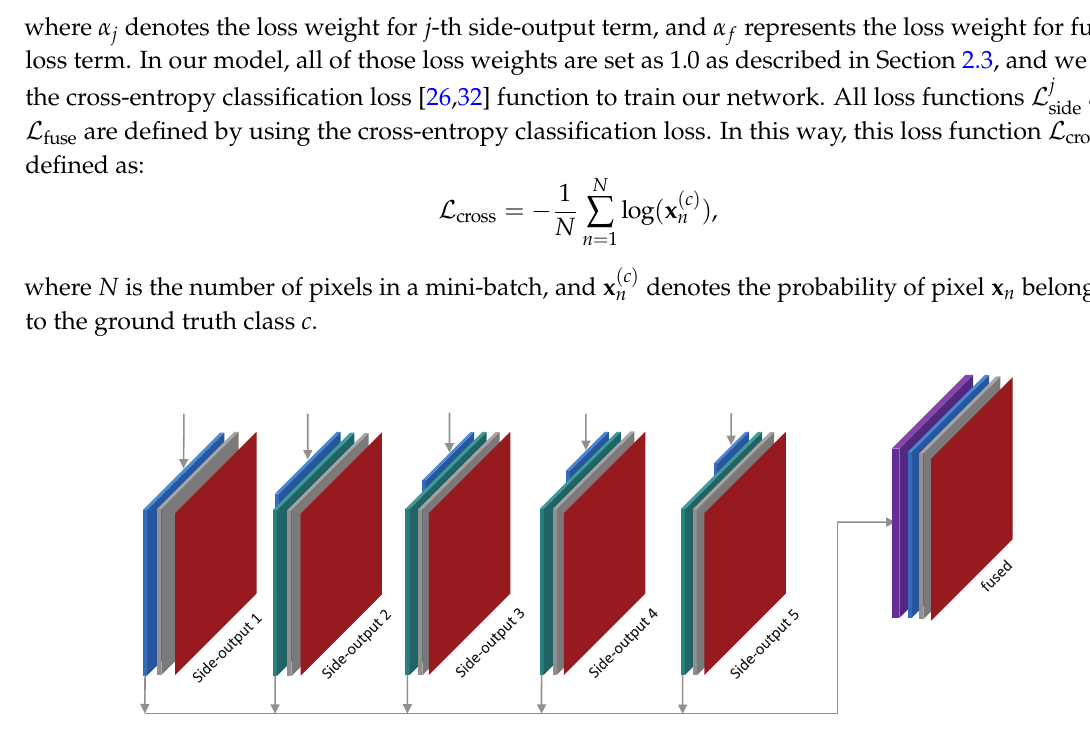
Figure 4. An illustration of side-output